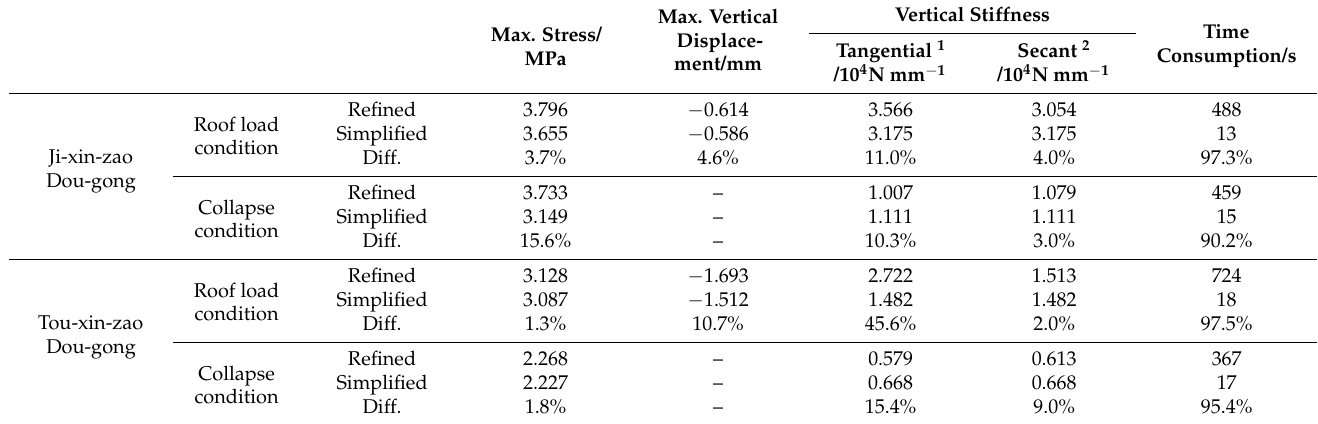
Table 5. Summary of the results of the two Dou-gongs: refined model vs. simplified